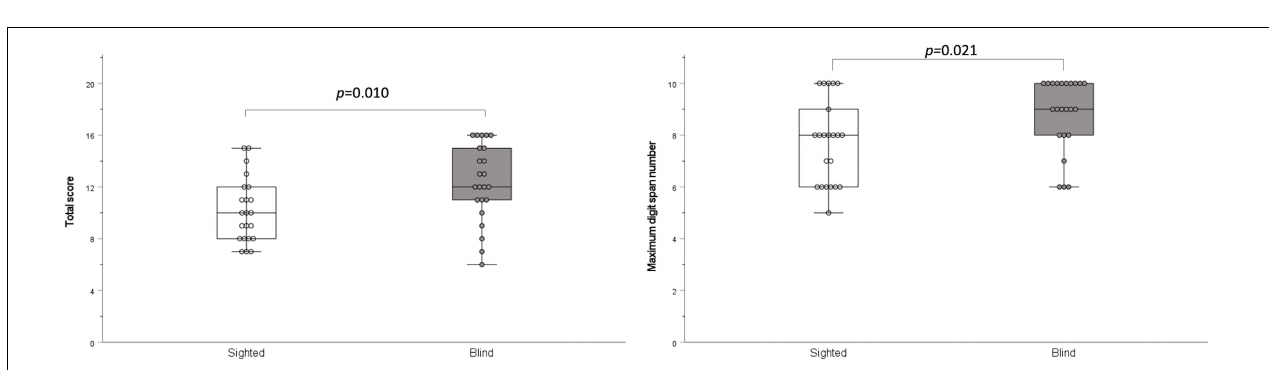
FIGURE 3 | Monosyllable perception in noise test. At signal-to-noise ratio (SNR)s of –4, 0, +4, and +8 under auditory-only (AO) conditions, there were no significant differences between the early-blind and sighted subjects, but the early-blind subjects tended to do better than the sighted subjects at an SNR of –8 ( p = 0.054). The scores of the sighted subjects under audio–visual (AV) conditions were much higher than those of the early-blind subjects and sighted subjects under the AO conditions ( p < 0.001). † 0.05 < p < 0.06.